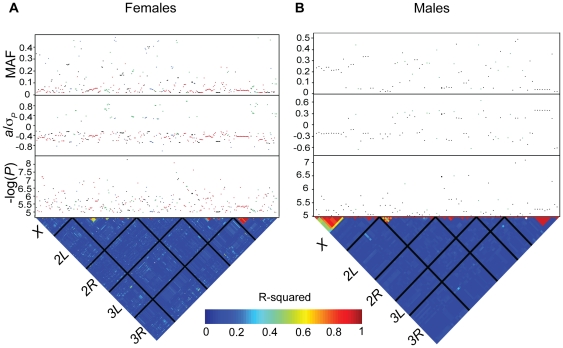
Genome-wide association analyses for females and males (treatments pooled).All SNPs from single marker analyses with a nominal P<10−5 are shown. Associations based on survival on paraquat are depicted by red dots, survival on MSB by blue dots, treatments pooled by black dots and SNP by treatment interaction by green dots. The lower triangle depicts the degree of LD between SNPs as measured by r2, with the five major chromosome arms demarcated by the black lines. The heat map indicates the magnitude of LD with red corresponding to complete LD and blue to absence of LD. The upper panels show the significance threshold (−log10
P), the effect size in phenotypic standard deviation units (a/σP), and the minor allele frequency (MAF). (A) Females. (B) Males.